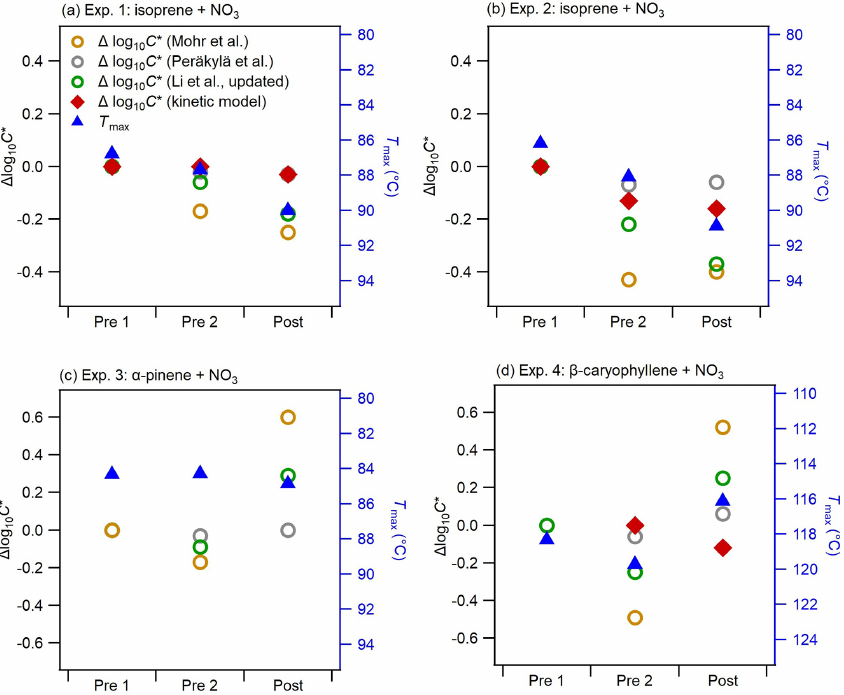
Figure 6. Comparison of changes in the bulk volatility measured with three methods before and after photolysis (Pre 1, Pre 2, and Post) for all experiments: Method 1 was (cid:49) log 10 C ∗ based on the parameterizations of Mohr et al. (2019), Li et al. (2016) (updated by Isaacman-VanWertz and Aumont, 2021), and Peräkylä et al. (2020); Method 2 was mass-weighted average T max (note the right axes are swapped, and the range in panel d is different from that in the other panels); and Method 3 was (cid:49) log 10 C ∗ from the kinetic model (data available only for Pre 2 and Post in Exp.